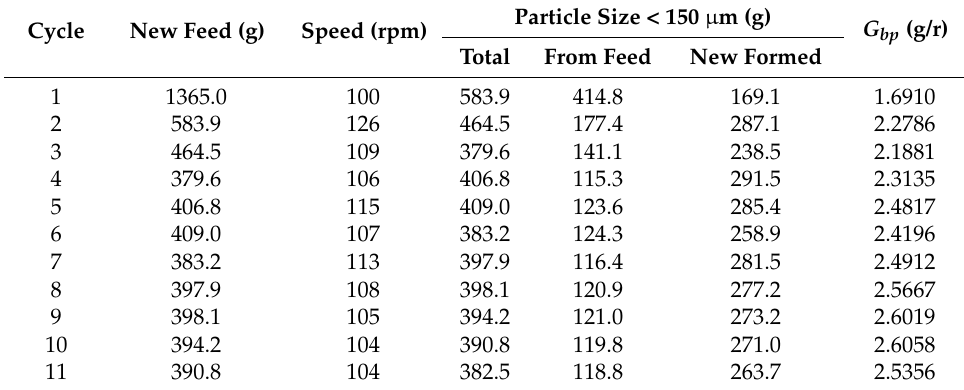
Table 4. The results of Bond ball work index test.